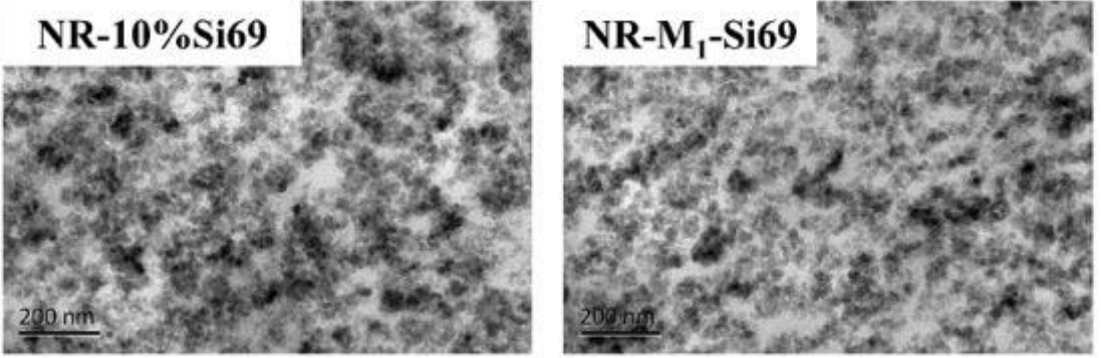
Figure 9. TEM images of NR – 10% Si69 and NR – M 1 – Si69.